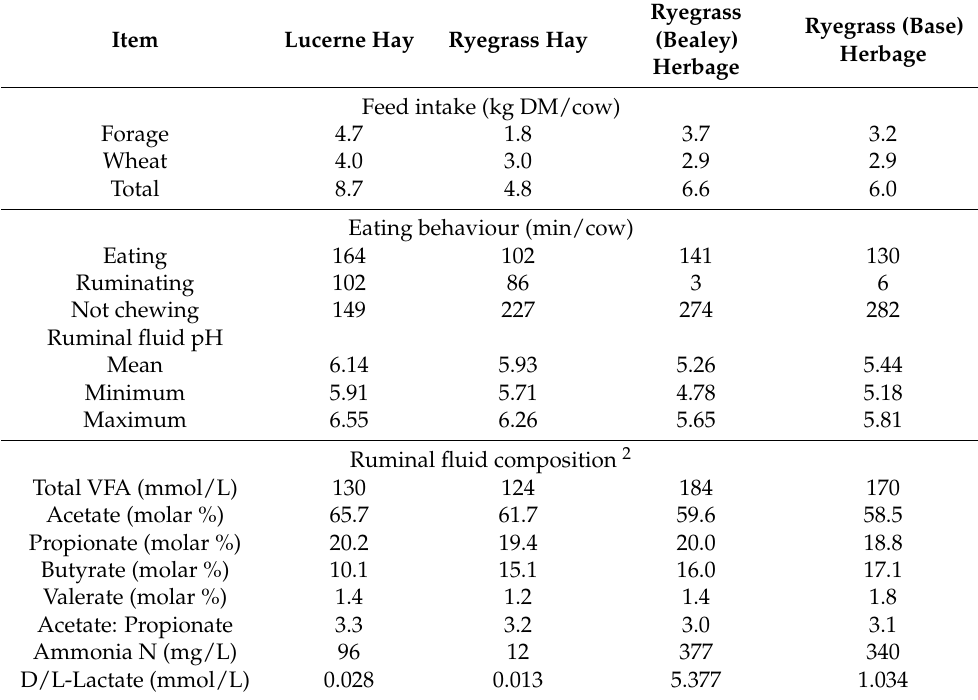
Table 6. Means of feed intake, eating behaviours, ruminal fluid pH and ruminal fluid composition of cows receiving each treatment as observed on day 4 of wheat inclusion 1 . Item Lucerne Hay Ryegrass Hay